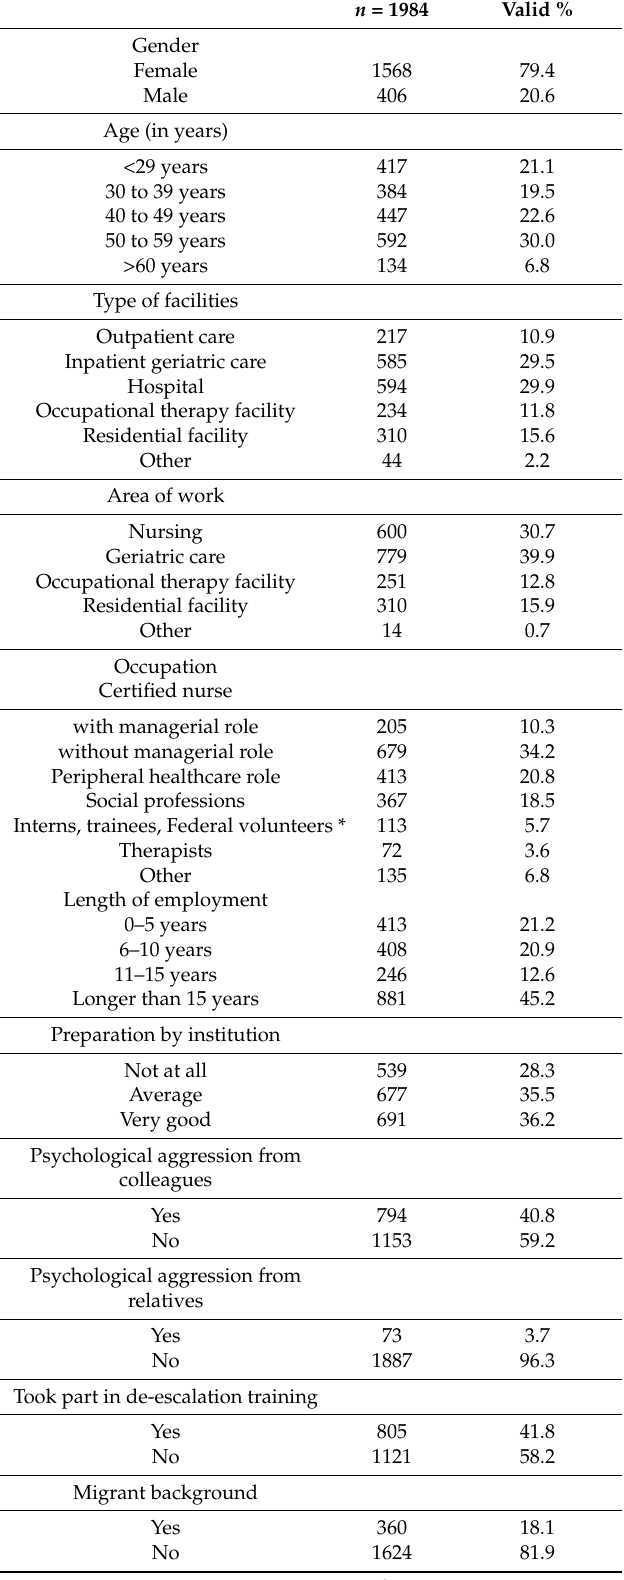
Table 1. Table 1. Description of study population ( n =